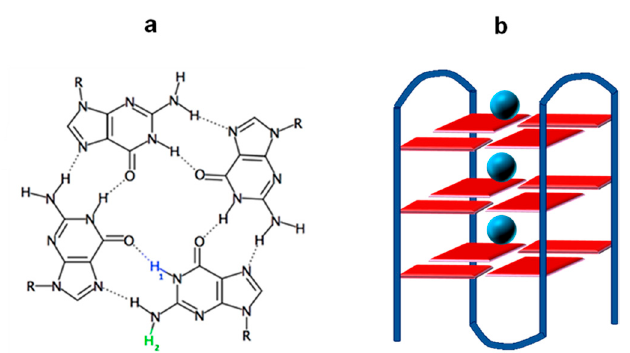
Figure 1. Schematic illustration of ( a ) the G -tetrad and ( b ) a G -quadruplex formed by folding of a single strand; blue circles represent metal ions located in the central cavity of the G -quadruplex. Transfer of the blue or green proton ( a ) to the aqueous solvent gives rise to ( G -H1) • or ( G -H2) • deprotonated radicals, respectively. Table 1. Quantum yields ( φ 1 × 10 3 ) determined at 266 nm for one-photon ionization of G -quadruplexes. TEL21 / Na +